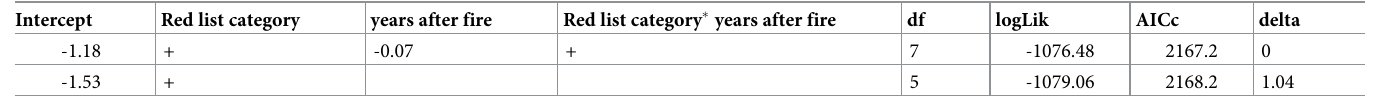
Table 2. Model selection table for Red list analysis with index.